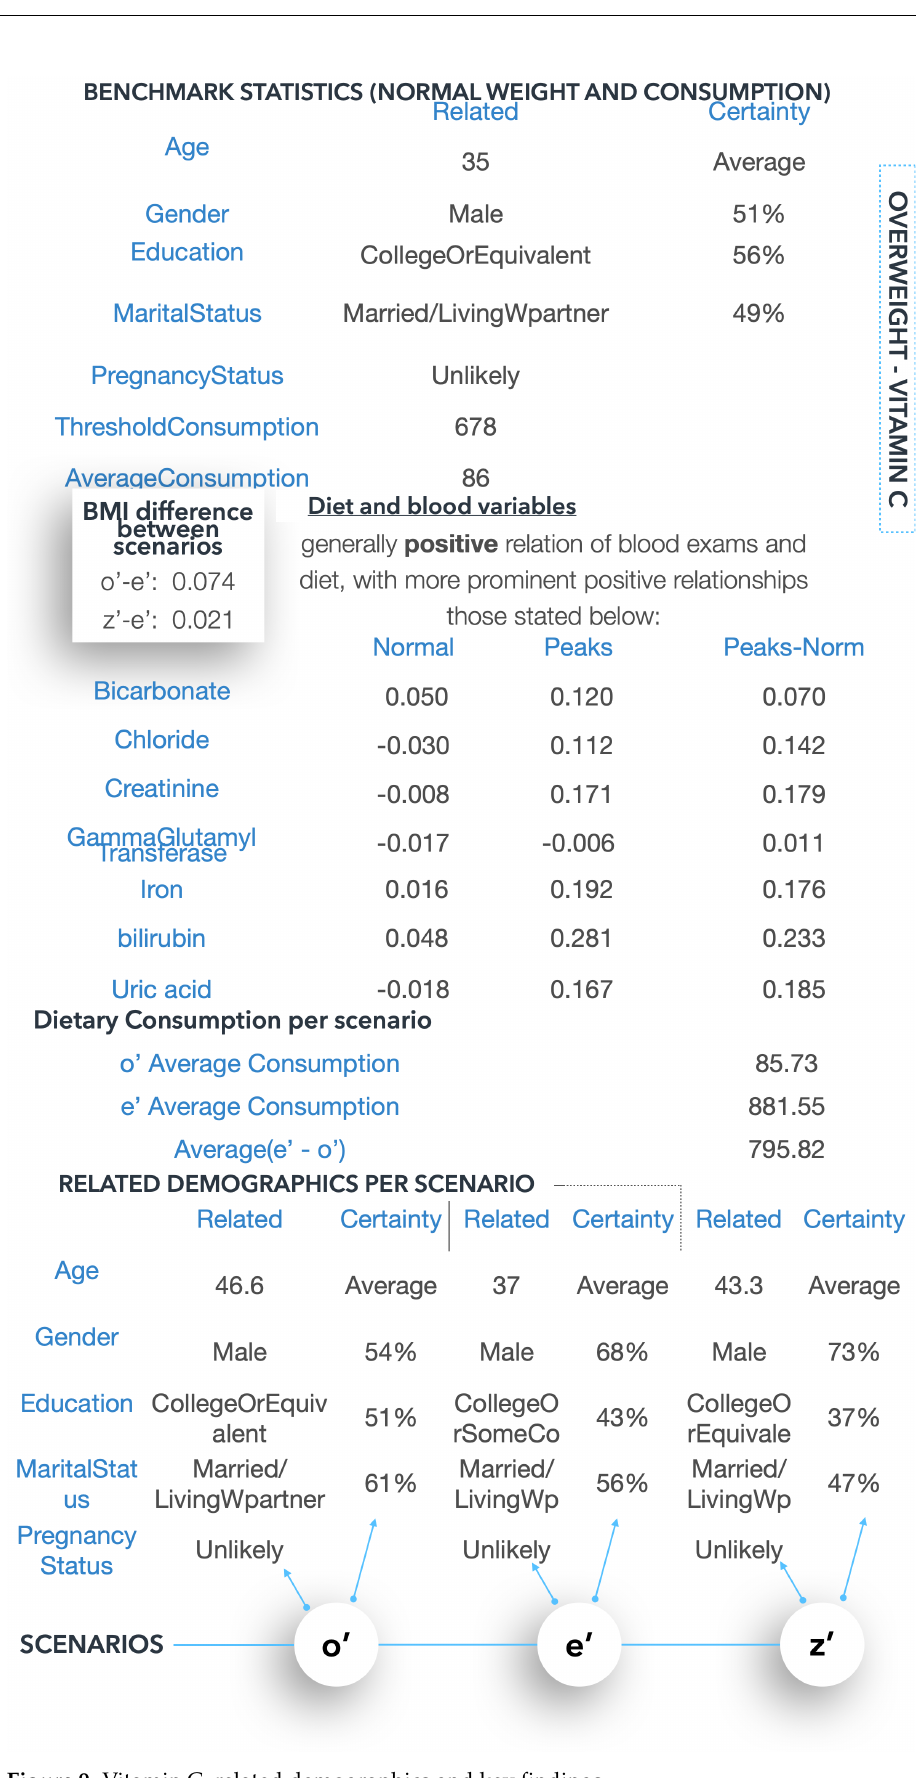
Figure 9. Vitamin C, related demographics and key